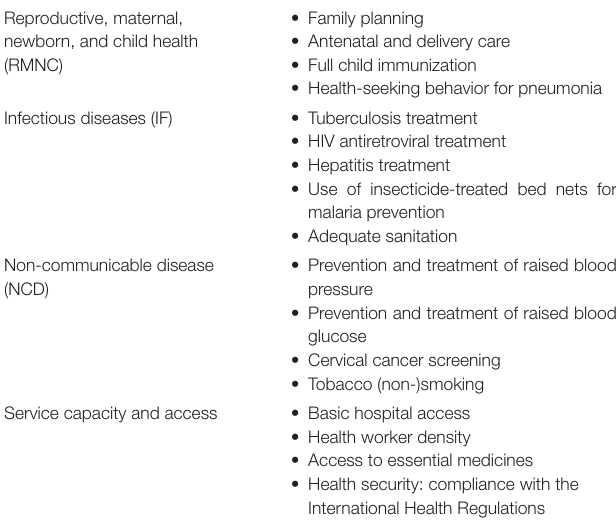
TABLE 1 | UHC indicators (73). Reproductive, maternal, newborn, and child health